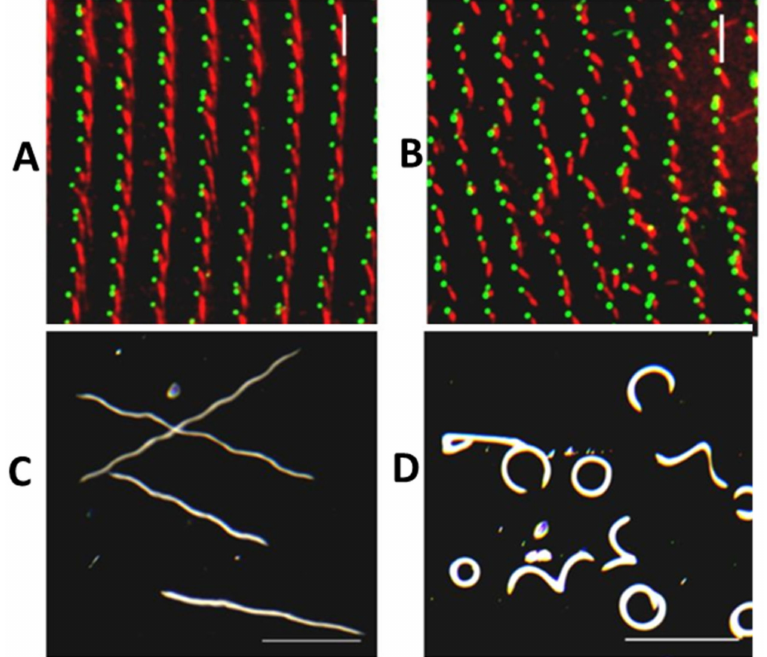
Figure 15. Striated Rootlet Disruption Control ( A , C ) and Structural Group 1 Depleted Cells ( B , D ). ( A , C ) Basal body row alignment and SR appearance in control cells ( A ) or cells with SR Structural Group 2 depleted by RNAi. Basal bodies are green (1D5 antibody) and SRs are red (anti-SR antibody). Note that in the Structural Group 2 SR RNAi treated cells, SRs are shorter and pointing in directions out of alignment with the basal body rows as in the Control Cell ( A ). ( B , D ) Swimming patterns of cells taken by darkfield microscopy. Shown here are Control ( B ) and Structural Group-1 depleted (by RNAi) cells ( D ). Scale bar is 1 mm. Reproduced from [90], with